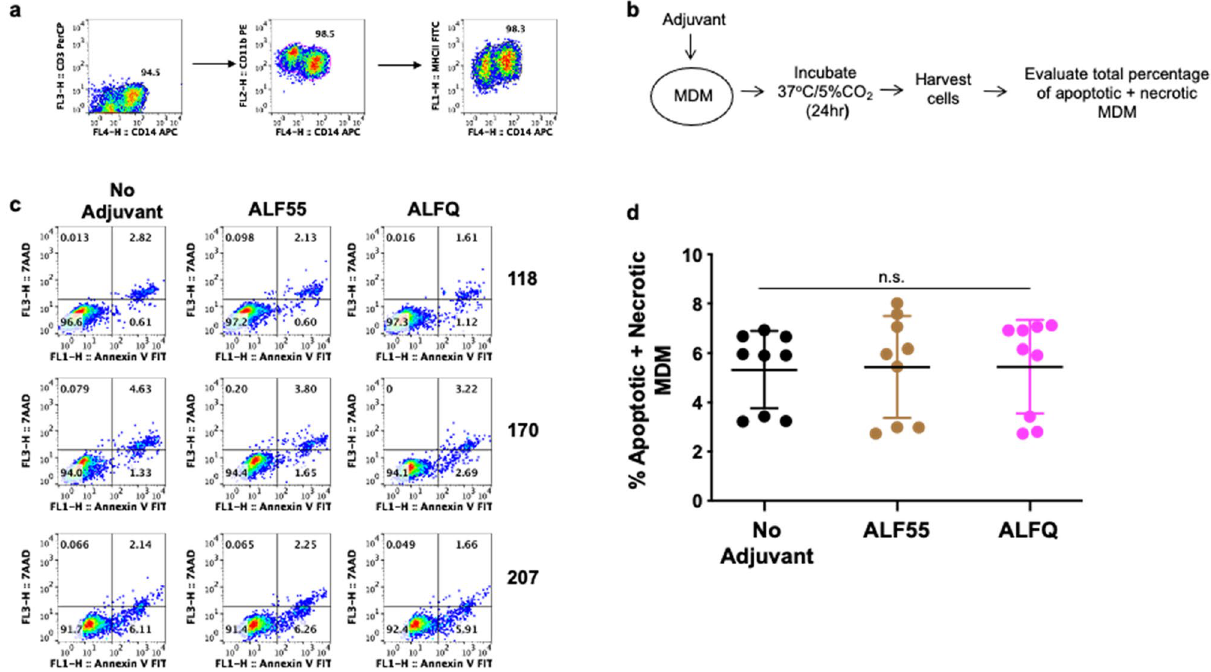
Figure 2. ALF55 and ALFQ do not induce apoptosis of MDM. Primary human monocytes were differentiated into MDM following in vitro culture with M-CSF media. ( a ) At day 4 post-culture, cells were harvested, stained and analyzed by flow cytometry. Plots show that the cells were CD14 + CD11b + MHCII + and did not contain CD3 + T cells. ( b ) Scheme showing MDM treatment with adjuvants. ( c ) Day 4 MDM cultures were treated with ALF55 or ALFQ for 24 h. Untreated MDM (no adjuvant) cultures served as controls. Cultures were harvested, stained with a cocktail of anti-CD14, Annexin V FITC and 7AAD. The total percentage of apoptotic and necrotic CD14 + cells was analyzed by flow cytometry. Values in the bottom right and upper right quadrant(s) of the plots represent the percentage of apoptotic and necrotic MDM, respectively under each treatment. ( d ) Scatter dot plots represent the data from triplicate wells from the 3 donors ( c ) and show that the total percentage of apoptotic and necrotic MDM (mean ± s.d.) were similar in the untreated, ALF55-treated or ALFQ-treated MDM, as determined by One-way ANOVA. Data is representative of two independent